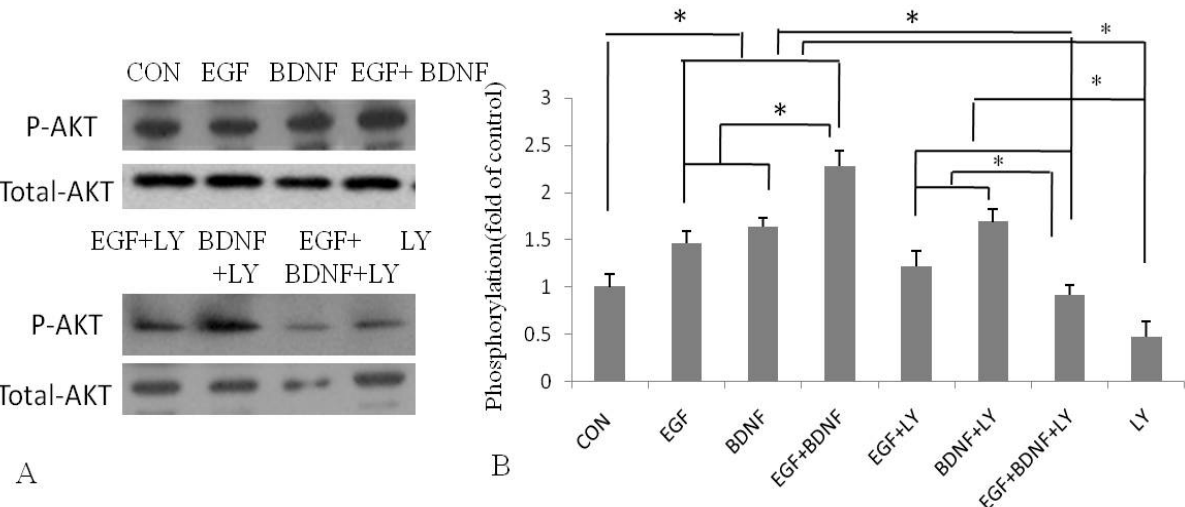
Figure 2. Western blot analysis phosphorylation and expression of AKT. NSPCs were pretreated with LY294002 (20 μ M) for 2 hours before exposure to EGF (20 ng/mL) and BDNF (50 ng/mL). ( A ) Western blotting analysis showed increased and decreased activation (phosphorylation) of Akt-1 with BDNF stimulation in NSPCs pretreated with or without LY294002, respectively; ( B ) Data are expreseed as the ratio of phosphorylated to total Akt-1. * p <